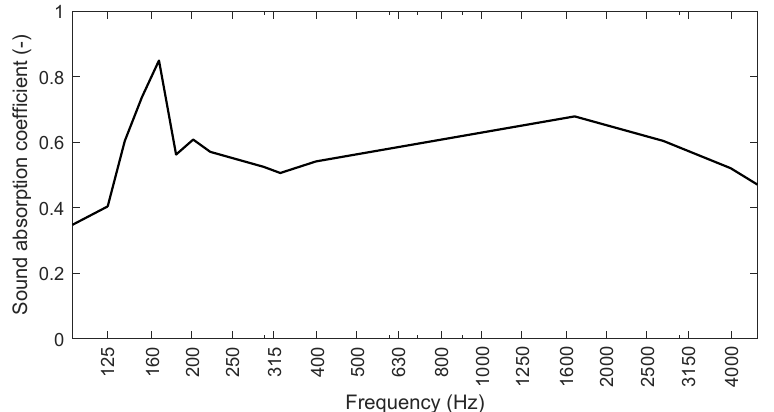
Figure 15. Sound absorption coefficient of the bricks chosen for the barrier (from